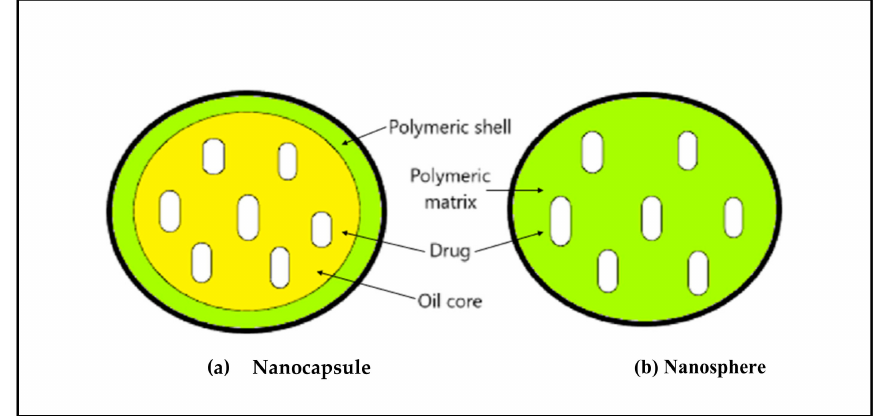
Figure 3. Schematic illustration of ( a ) nanocapsule; and ( b )